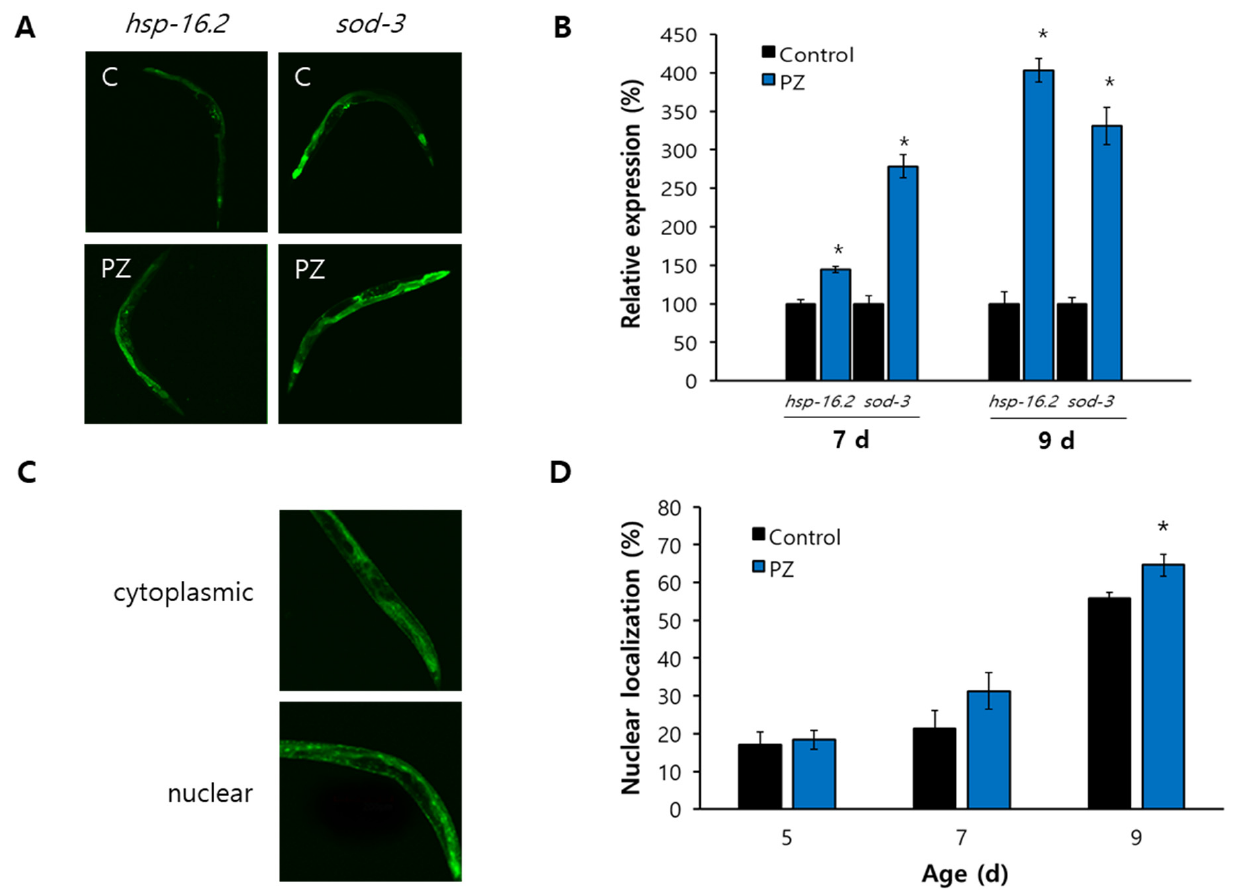
Figure 4. Transcriptional regulation of stress-responsive genes by phlorizin. ( A ) GFP expression induced by either hsp-16.2 or sod-3 promoter was observed in a fluorescence microscope. ( B ) Quantification of fluorescence was determined using a fluorescence multi-reader. Relative percent expression is shown compared to 100% for untreated control. ( C ) Subcellular localization of DAF-16 fused to GFP was determined under a fluorescence microscope. ( D ) Percent of worms showing nuclear localization was compared between untreated control and phlorizin-treated group. Error bar indicates standard error. C, untreated control; PZ, phlorizin (10 μ M); *, a significant difference ( p < 0.05) compared to untreated control.